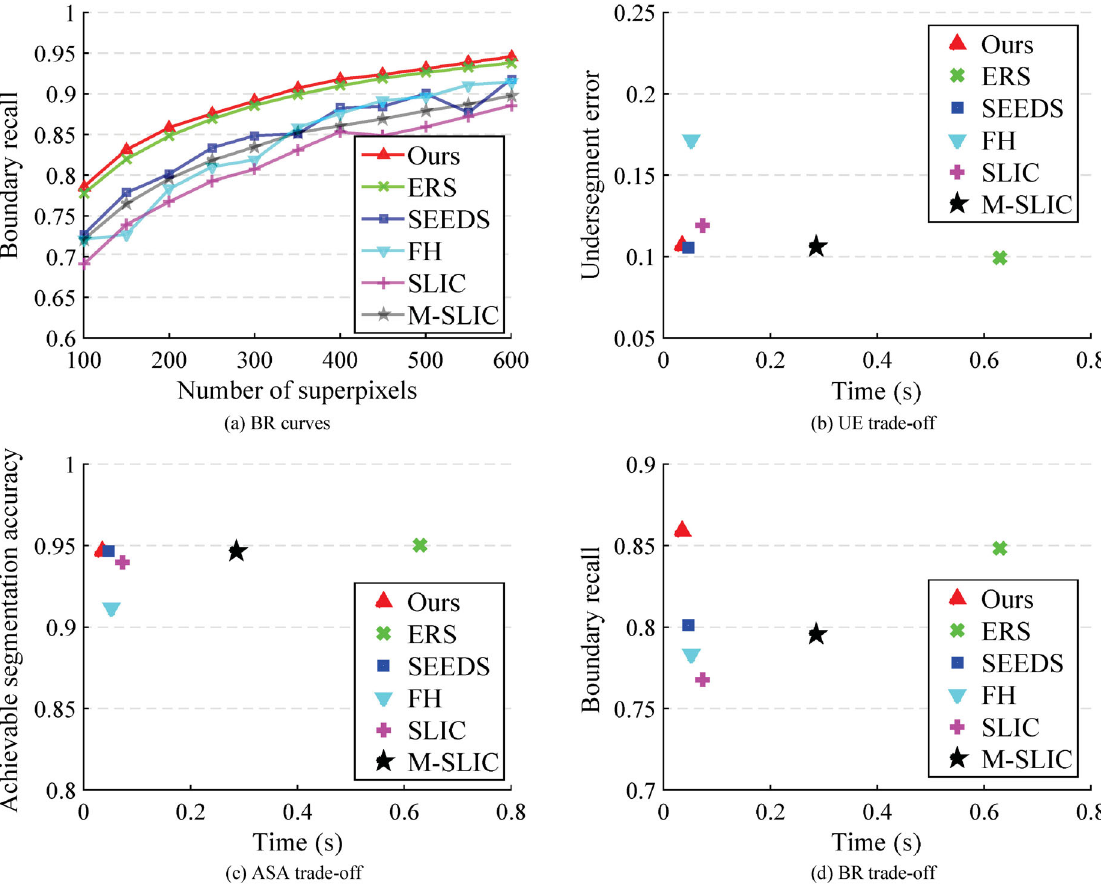
Fig. 5 Comparisons between state-of-the-art methods and our approach on the BSDS500 benchmark. In (b)–(d), K is fixed to 200 for the best trade-off between result quality and speed. In terms of boundary recall, our strategy significantly outperforms methods that take similar time. Furthermore, competitive results are also achieved compared to slower methods (e.g., the state-of-the-art ERS method [16]) according to all evaluation metrics, but at an order of magnitude faster